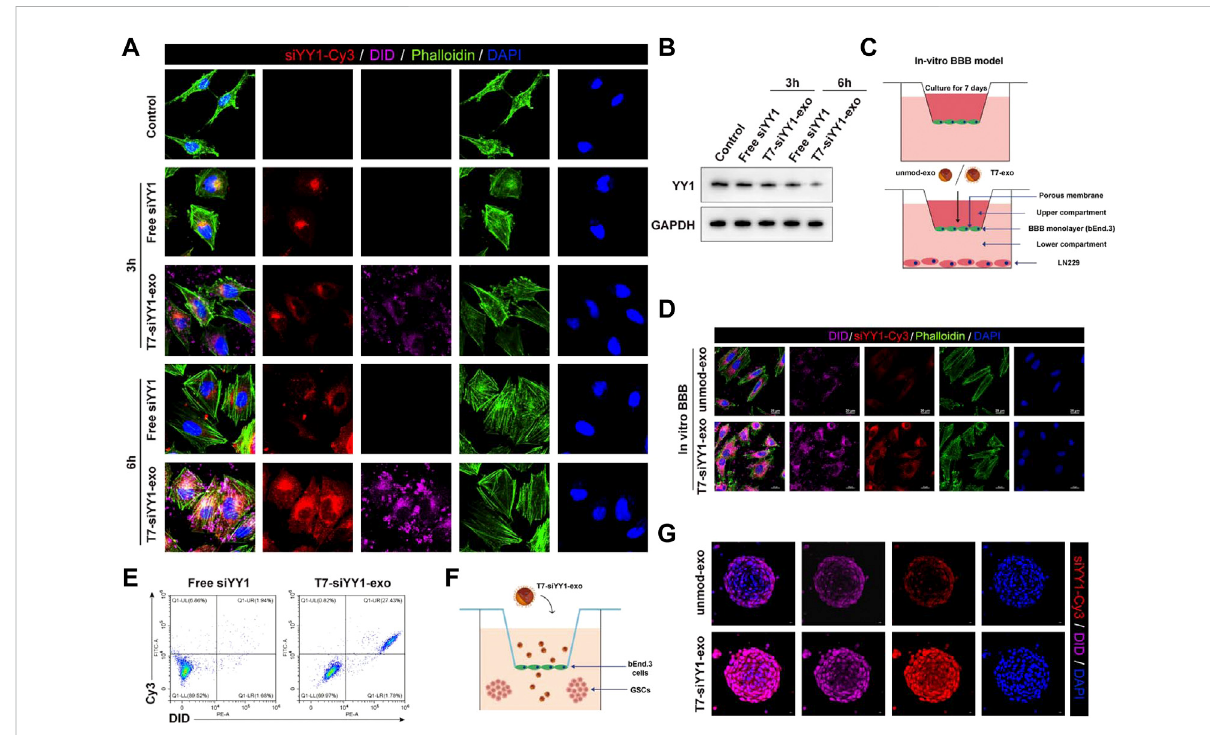
FIGURE 2 Cellular uptake of T7-siYY1-exo in vitro and BBB/BBTB model. (A) The delivery ef fi ciency of Free siYY1 and T7-siYY1-exo in LN229 cells. Cy3- labeled siYY1 and loaded DID-labeled exosomes (5 μ g/ml) were used to treat LN229 cells. After 24h incubation, the cytoskeleton was stained with phalloidin and the cell nuclei were stained with DAPI. The fl uorescent was photographed under a confocal laser scanning microscope using Nikon NIS-Elementssoftware(Nikon,Tokyo,Japan). (B) Theknockdownef fi ciencyofYY1wasdetectedbyWesternblot. (C) Schematicdiagramofthe BBB model in-vitro . (D) Representative immuno fl uorescence images showing T7-siYY1-exo uptake into LN229 cells after passing through a bEnd.3 monolayer. Unmod-exo/T7-siYY1-exo (5 μ g/ml) was added to upper compartment. The fl uorescent was photographed under a confocal laser scanning microscope using Nikon NIS-Elements software (Nikon, Tokyo, Japan). (E) The positive rates of DiD and Cy3 were detected by fl ow cytometry. (F,G) The penetrating and tumor targeting ef fi cacy of T7-siYY1-exo evaluated through BBTB/LN229 tumor spheroids co-culture model. The treatment concentration of unmod-exo/T7-siYY1-exo was 5 μ g/ml. The fl uorescent was photographed under a confocal laser scanning microscope using Nikon NIS-Elements software (Nikon, Tokyo,